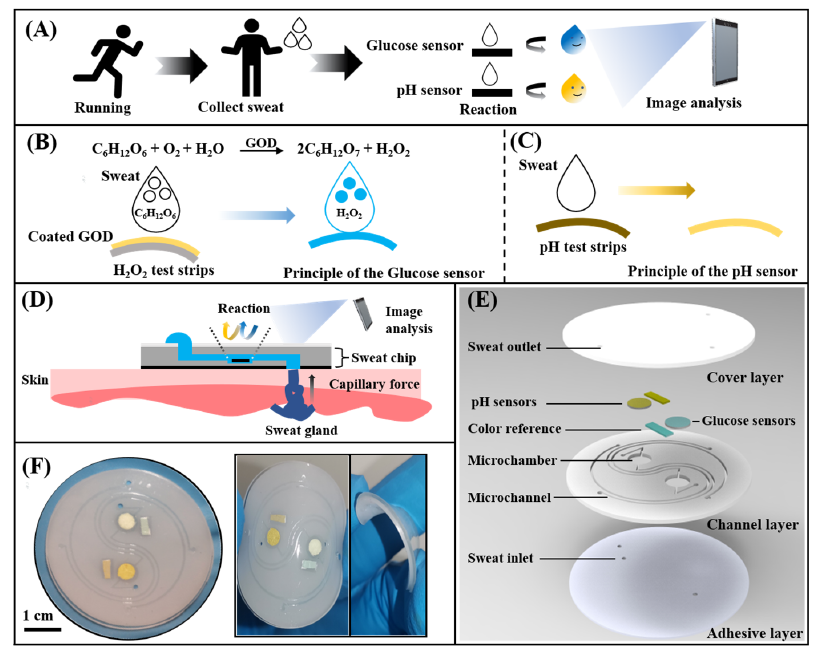
Figure 1. Schematic and optical images of the microfluidic sweat chip. ( A ) Conceptual diagram of the microfluidic sweat chip. ( B , C ) Principle of the glucose sensor and pH sensor. ( D ) Schematic of the sweat collection using the microfluidic sweat chip. ( E ) Schematic diagram of the microfluidic sweat chip structure. ( F ) Image of the microfluidic sweat chip.